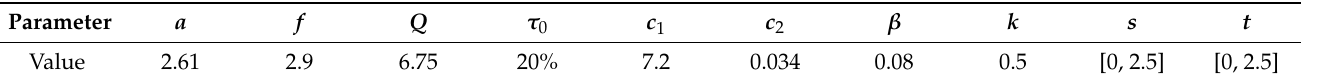
Table 3. Summary of parameter